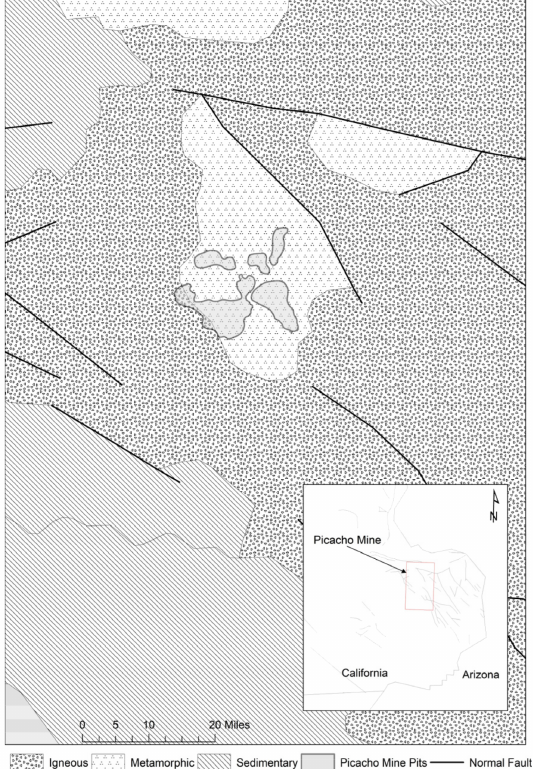
Figure 1. Map showing the location of the Picacho mine. Data from